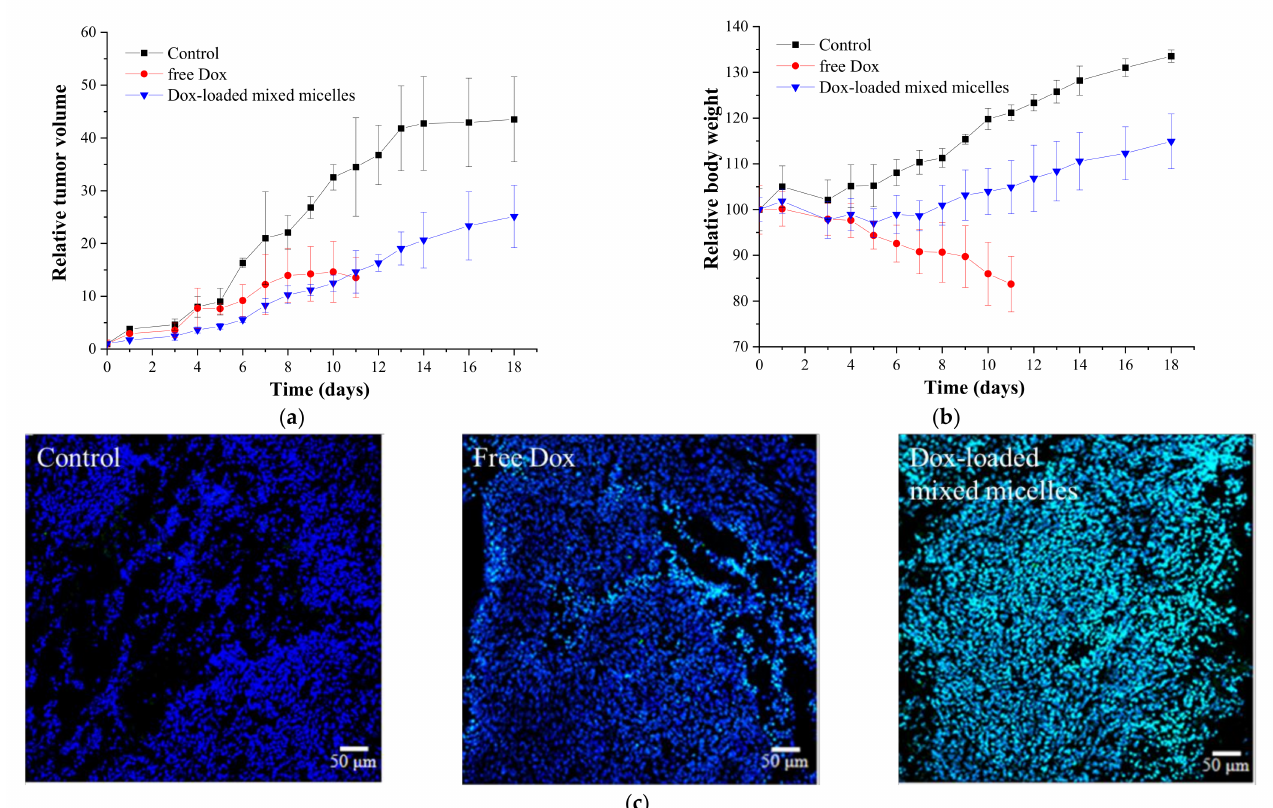
Figure 6. In vivo antitumor efficiency and toxicity evaluation. ( a ) In vivo anticancer efficacy and ( b ) body weight changes in LL/2 mouse Lewis lung cancer cells borne by BALB/c nude mice detected after intravenous administration of saline (control), 5 mg/kg doxorubicin (free Dox), and 20 mg/kg Dox-loaded mixed micelles at day 0, 3, and 6. ( c ) TUNEL apoptotic cell detection of tumor cells in tumor-bearing mice 14 days after intravenous administration of saline, 10 mg/kg of free doxorubicin, and Dox-loaded mixed micelles. Green, apoptotic cells; blue,